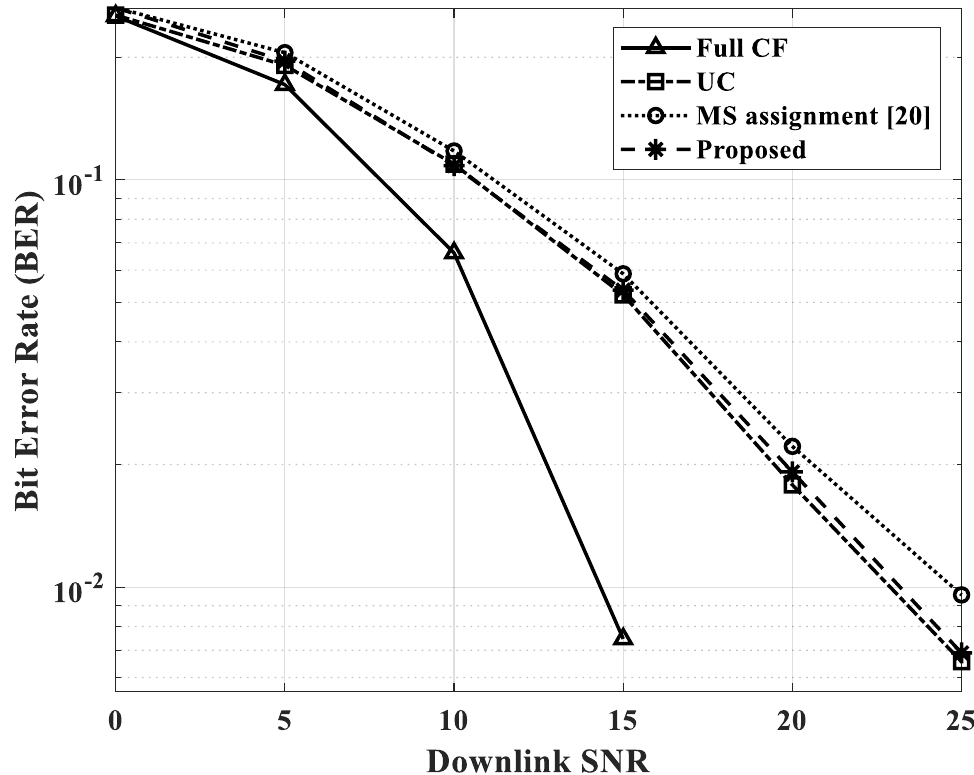
Figure 6. BER performance for four